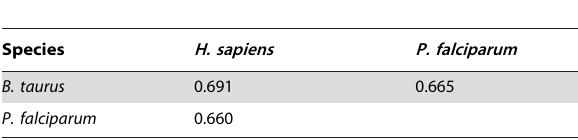
Table 2. Similarity of reaction-coupled modes in